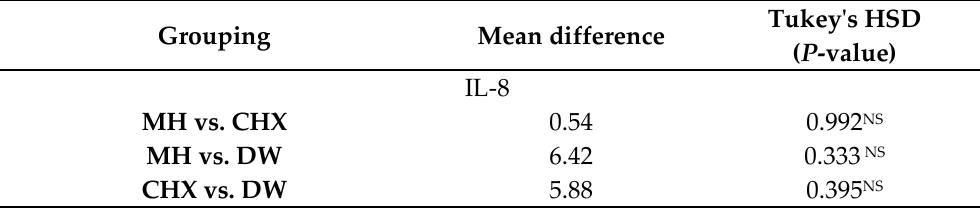
Table 5: intergroup comparisons of mean values of IL-8 between all pairs of groups after mouth- wash